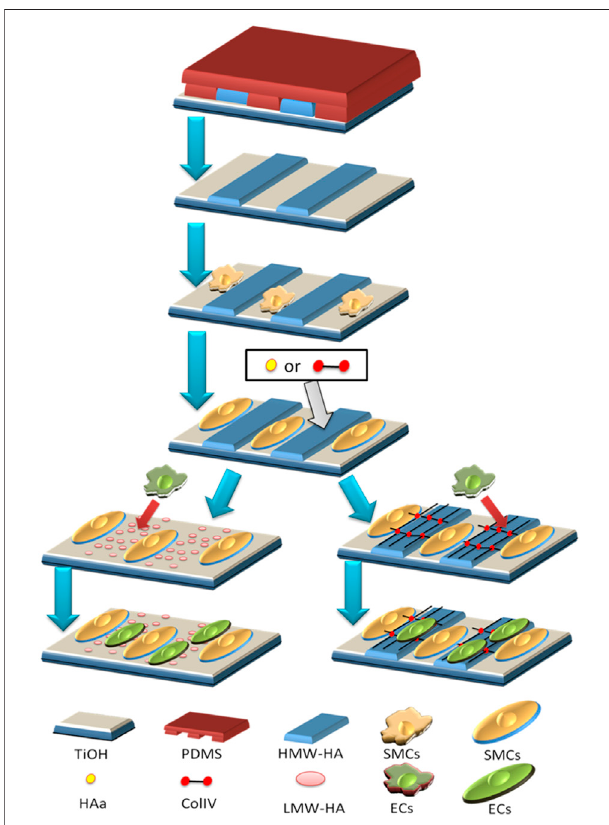
FIGURE 5 | Two co-culture models of EC/SMC on the HA micro- pattern: SMC was fi rst regulated to the contractile phenotype; in model 1, hyaluronidase was added to break down high molecular weight HA into low molecularweight HA,andthelatter inducedEC togrow onitssurface;in model 2, type IV collagen was added to cover the HA micro-pattern and the patternedSMC,andthentypeIVcollagenpromotedECtogrowonitssurface (Li et al.,